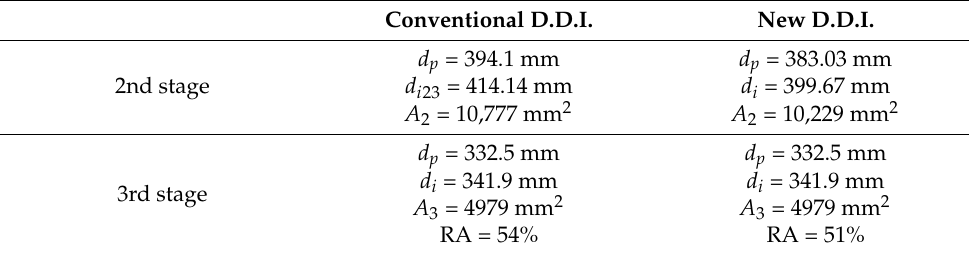
Conventional D.D.I. New